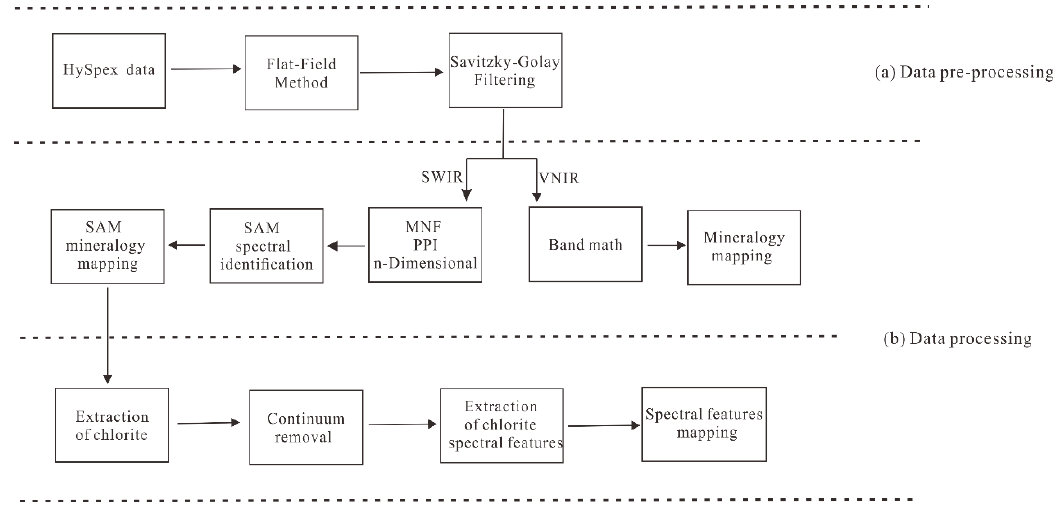
Figure 6. The laboratory-based hyperspectral imaging processing model.